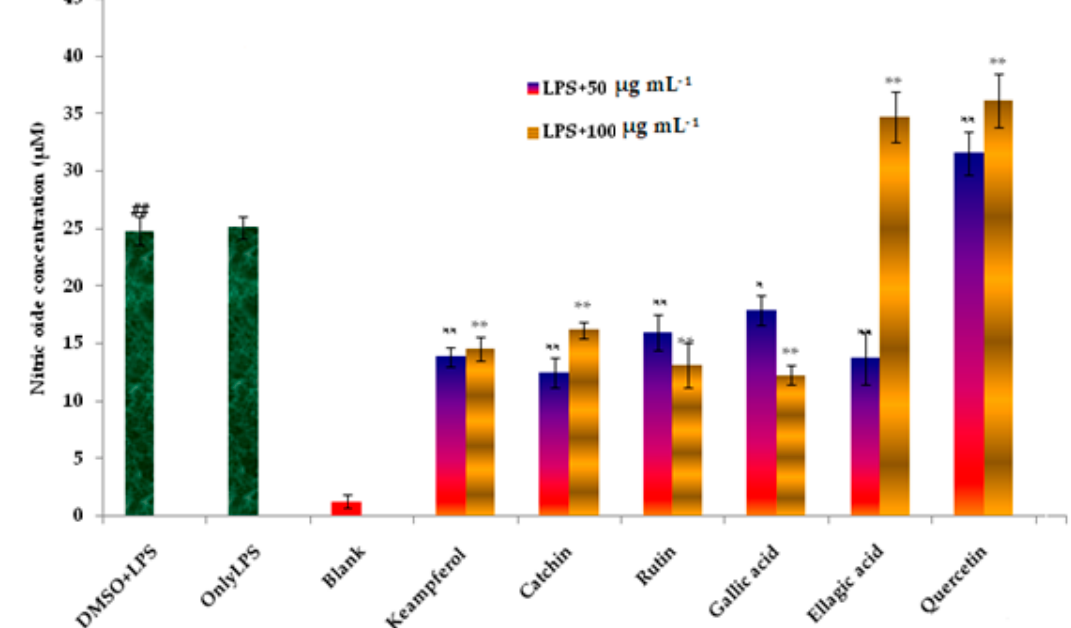
Figure 4. Effect of polyphenols on NO levels in LPS-stimulated RAW 264.7 cells. Cells (2 × 10 4 cells /well) in 96-well plates were first incubated with and without indicated concentrations of polyphenols for 2 h and then incubated with LPS (10 μ g mL − 1 ) for 20 h. ## LPS treated. Untreated is the negative control without LPS treatments. Values are expressed as mean ± SEM. ns: non-significant, n = 3, data ± S.E.M. Groups 3–7 were compared against group II using Dunnett’s post-hoc test (* significant at < 0.01; ** significant at < 0.001).